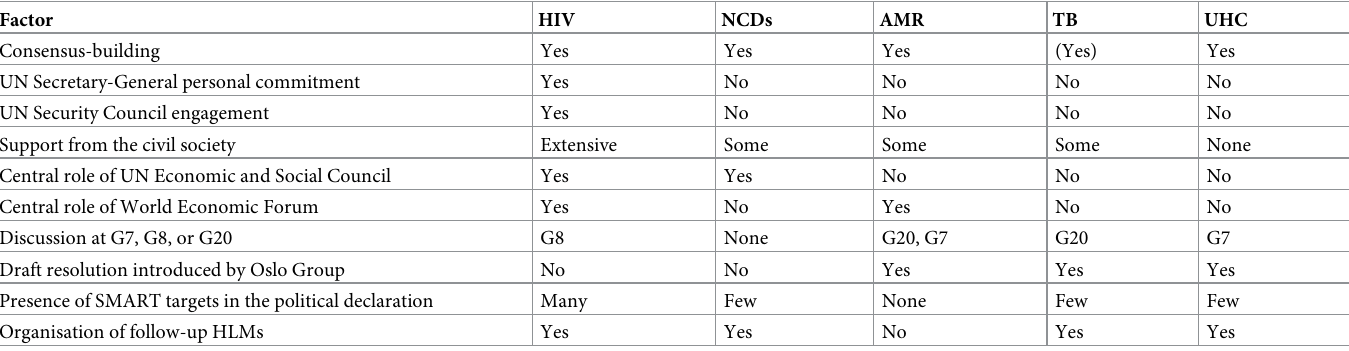
Table 2. Main factors AU : ThecellsinTable 2 containedamixofwordsandundefinedsymbols : Ireplacedallofthesymbolswithwords : Pleasecheckthatthewords ð especiallyforSupportfromthecivilsociety Þ areappropriate : influencing the preparatory process of health-related UN events AU : PleasecheckthattheeditstothetitleofTable 2 captureyourmeaning : Ifnot ; pleaseprovidecorrectwording : .